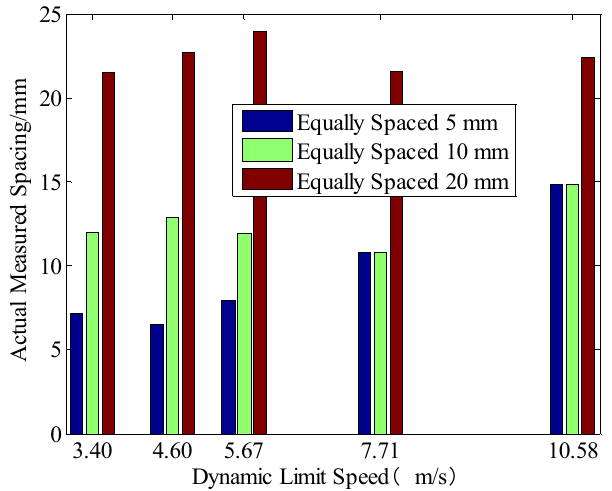
Figure 6. The relation between dynamic limit speed and actual measured interval. The dynamic indication error is smallest when the measurement distance is 3 m, indicating that the fitted diameter at a distance of 3 m is closest to the diameter of the circular trajectory generator. Figure 7 shows the relationship between measurement distance and dynamic indicating value error. For example, when the measurement distance is 1 m and the equal spacing of the laser tracker is set to 5 mm, 10 mm, and 20 mm, the dynamic indication error is − 0.0253 mm, − 0.0273 mm, and − 0.0191 mm, respectively. When the measurement distance is 2 m and the equal spacing of the laser tracker is set to 5 mm, 10 mm, and 20 mm, the dynamic indication error is − 0.0146 mm, − 0.0194 mm, and − 0.0143 mm, respectively. When the measurement distance is 3 m, the dynamic indication error is − 0.0117 mm, − 0.0026 mm, and 0.0020 mm, respectively.